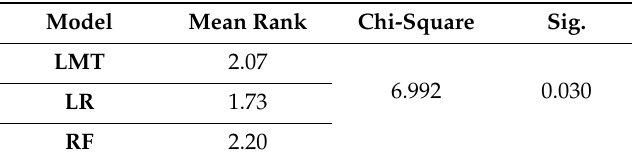
Table 6. Friedman statistic test to check significant di ff erence among models.